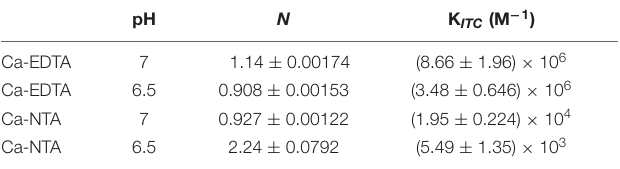
TABLE 1 | Ca 2 + -EDTA/NTA binding parameters at 25 ◦